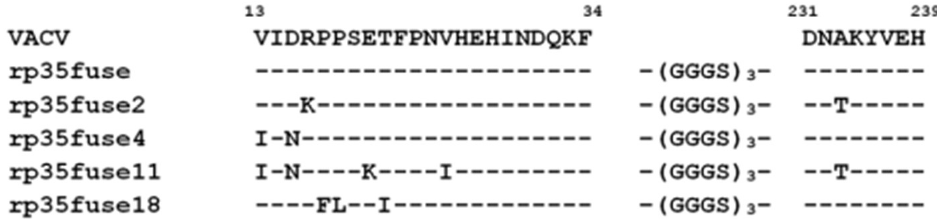
Figure 5. Alignment of rp35Δfuse mutant variants. Purified rp35Δfuse2, rp35Δfuse4, rp35Δfuse11, and rp35Δfuse18 proteins were sub-